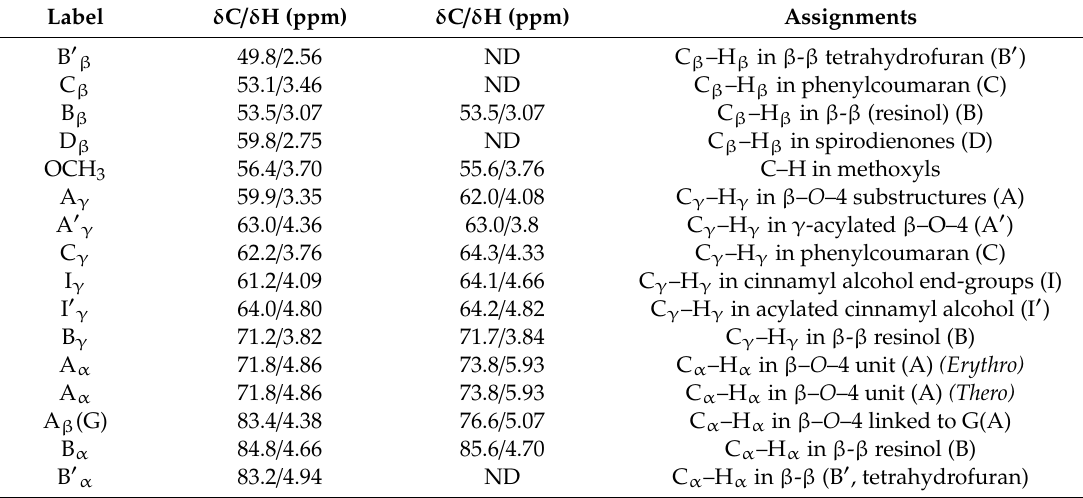
Figure 4. Main classical structures in the lignin preparations: ( A ) β – O –4 ether linkages; ( B ) resinol structures formed by β - β ’ / α - O - γ ’ / γ - O - α ’ linkages; ( C ) phenylcoumarane structures formed by β -5 ’/ α - O -4 ′ linkages; ( FA ) Ferulates guaiacyl unit; ( S ) syringyl unit; ( H ) p-hydroxyphenyl units ( G ) guaiacyl units. Table 2. Assignments of 13 C- 1 H cross signals in the HSQC spectra of the lignin.